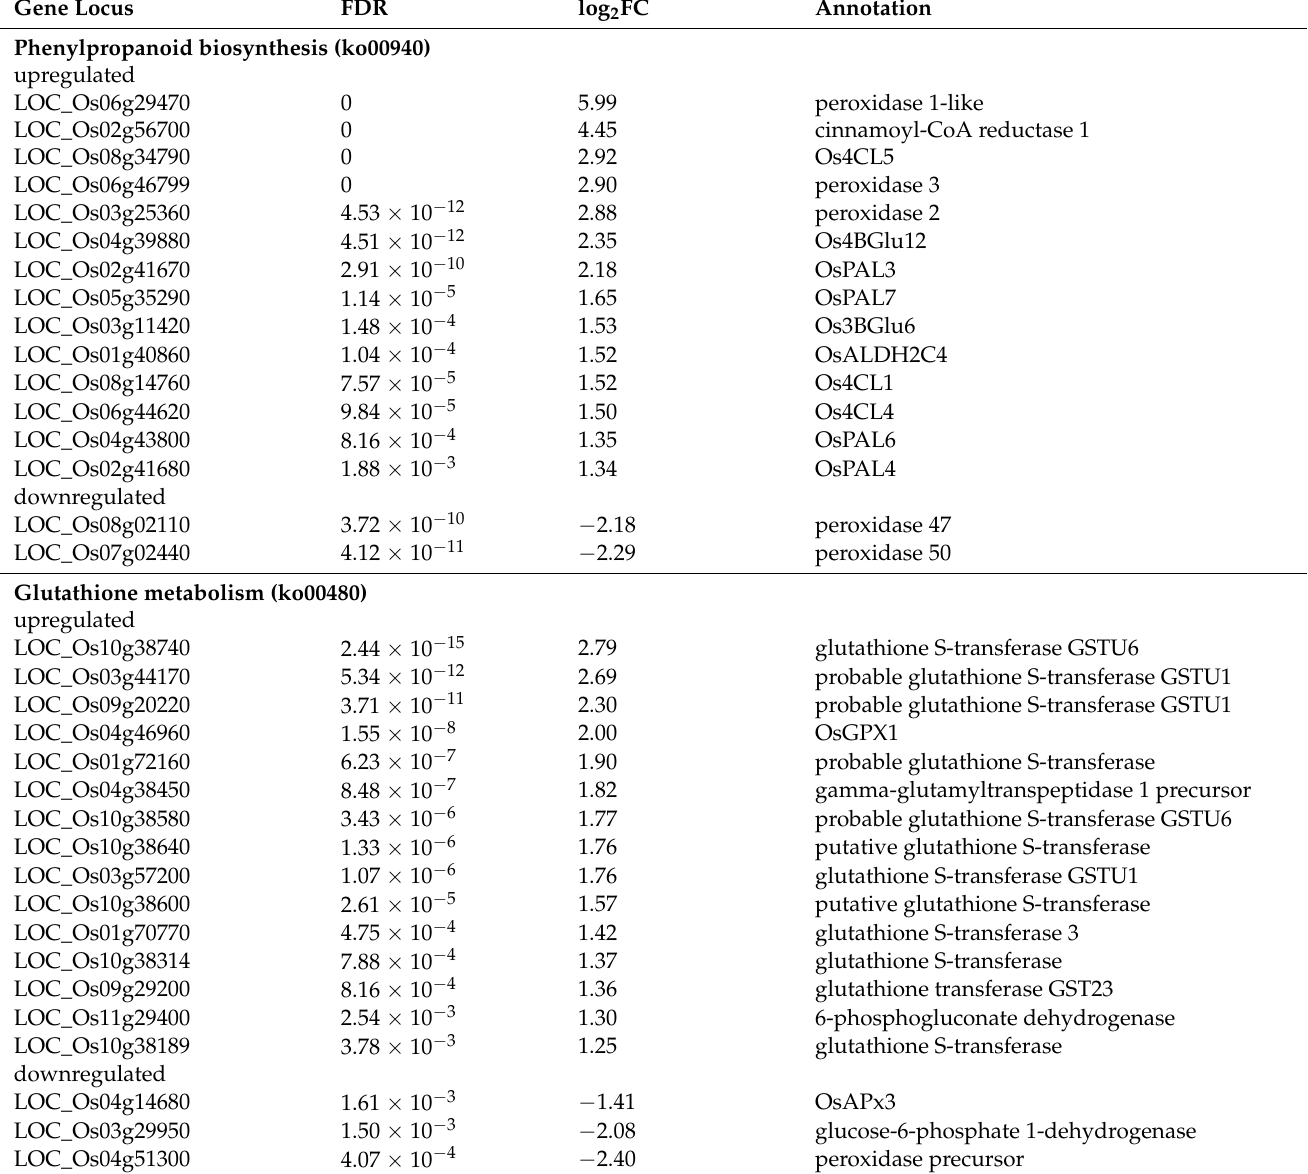
Table 3. The candidate DEGs involved in phenylpropanoid biosynthesis and glutathione metabolism pathway in 1/4N_1N